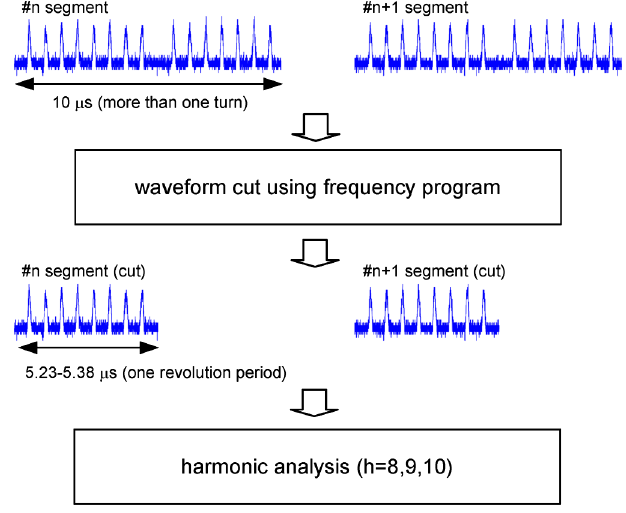
FIG. 8. A schematic of segmented waveform data